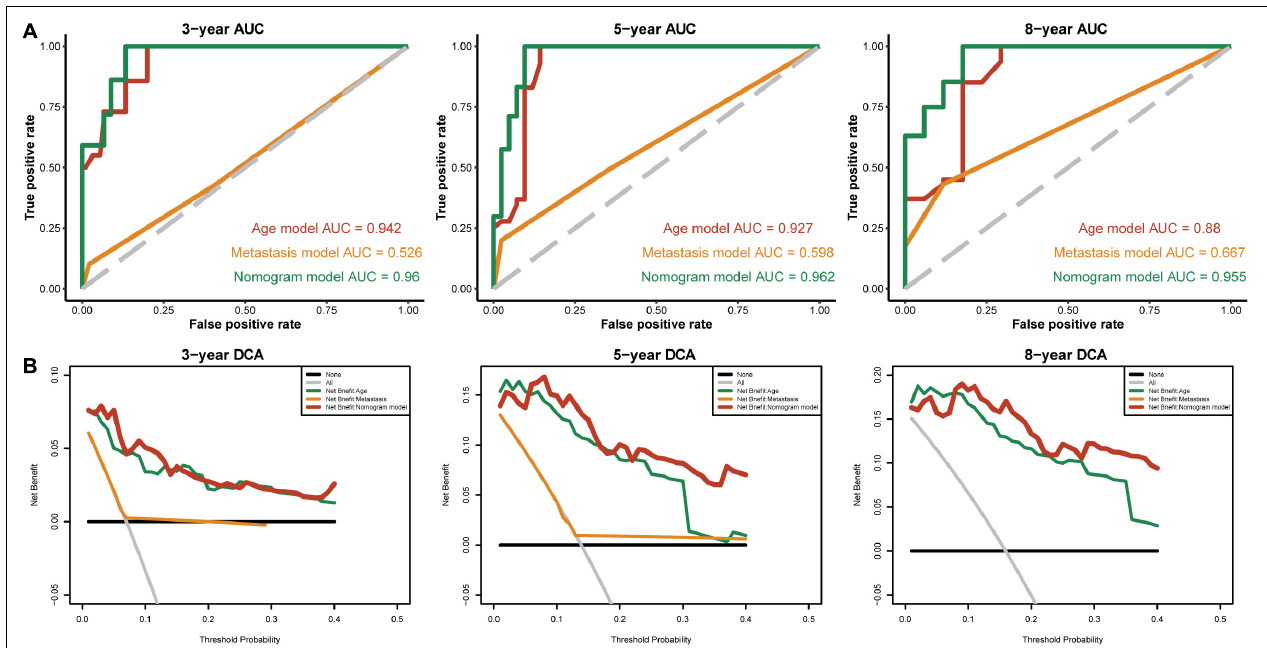
FIGURE 9 | The time-dependent ROC and DCA curves of the nomogram. (A) The time-dependent ROC curves of the different nomograms compared for 3-, 5-, and 8-year overall survival in the entire cohort. (B) The DCA curves of the different nomograms compared for 3-, 5-, and 8-year overall survival in the entire cohort. The 8-year DCA curves of metastasis are not shown, as the calculated net benefit were all smaller than calculated with the none